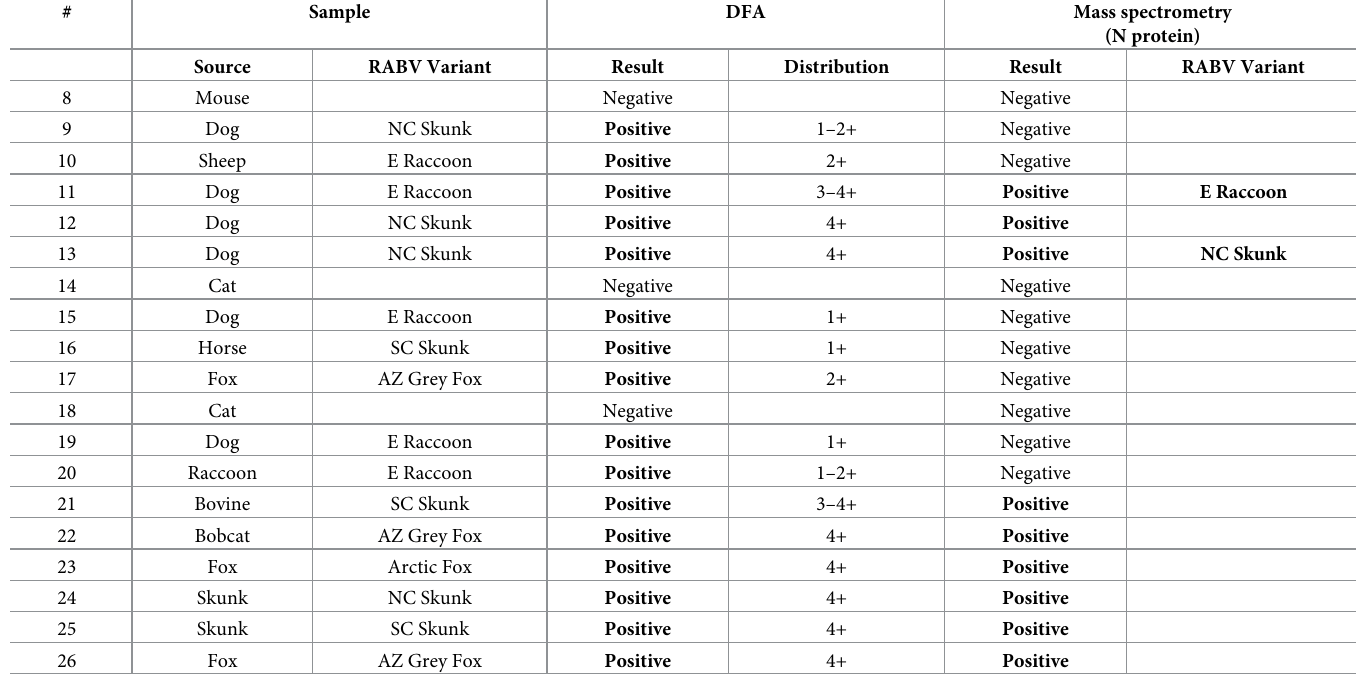
Table 1. The results from MS analysis of CNS